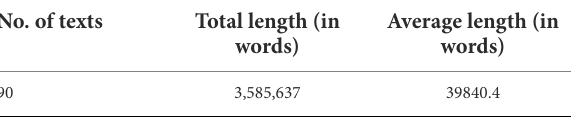
TABLE 1 Description of the